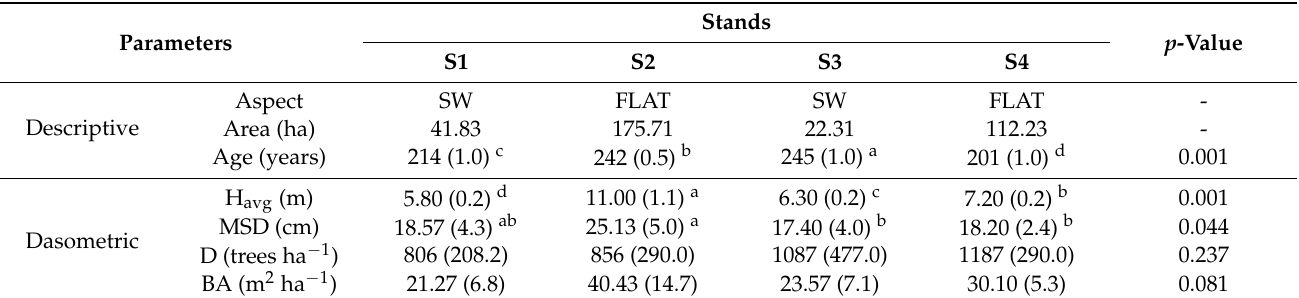
Table 2. General background of the stands measured. H avg = average height; MSD = mean square diameter; D = density; BA = basal area.